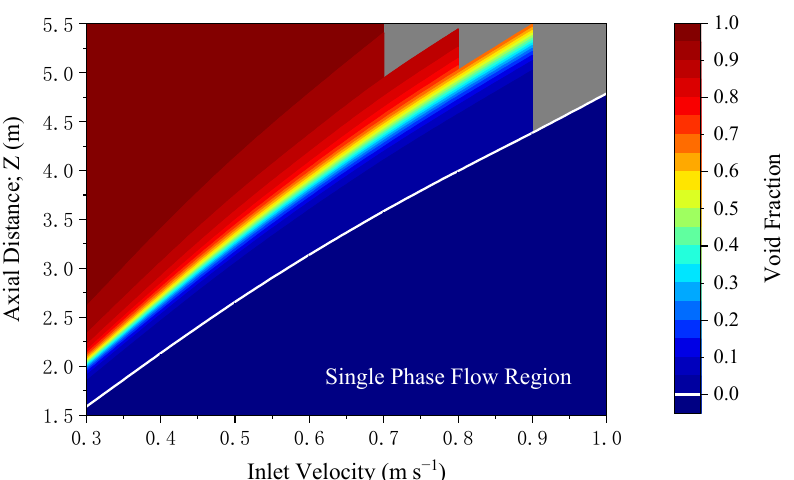
-20% Figure 6. Heat transfer coefficient comparisons between simulated results and Chen’s correlation. 3. Results and Discussion 3.1. Void Fraction and Quality Figure 7 shows the void fraction profiles along the axial direction of cases with different inlet velocity and Figure 8 shows that of cases with different pipe wall emissivity, which are listed in Table 2. The average void fraction of a specific cross-section can be quickly obtained from Figures 7 and 8 as long as the operating condition matches. The void fraction of the cases listed in Table 2 is the exact value, and for operating conditions not listed in the tables, the values are obtained by cubic spline interpolation. In Figure 7, for the conditions under which the void fraction value cannot be obtained from either the exact simulation data or the interpolation, it was represented in gray. The white line is the